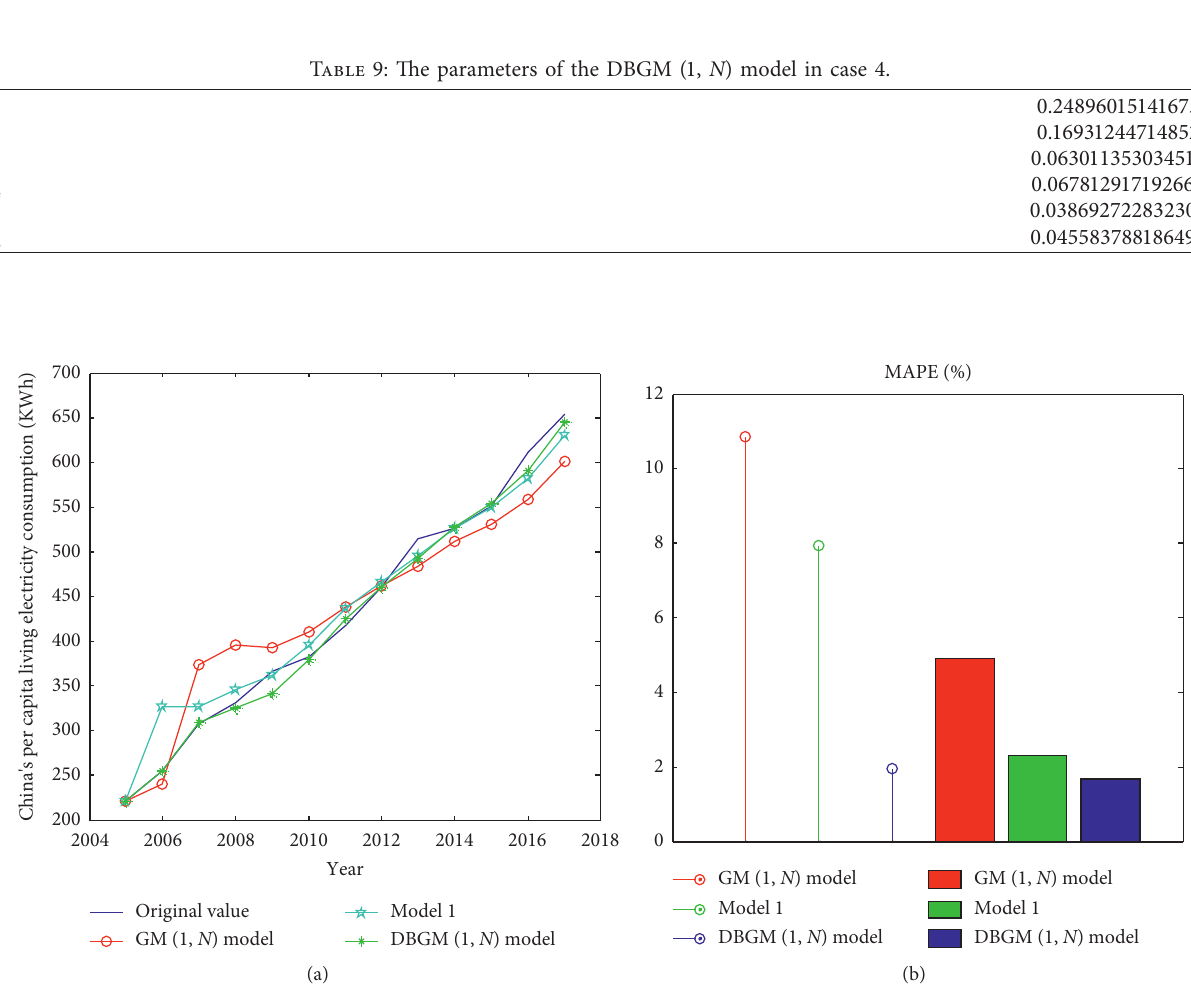
Figure 4: Schematic of the prediction results and MAPEs of the three prediction models (Case